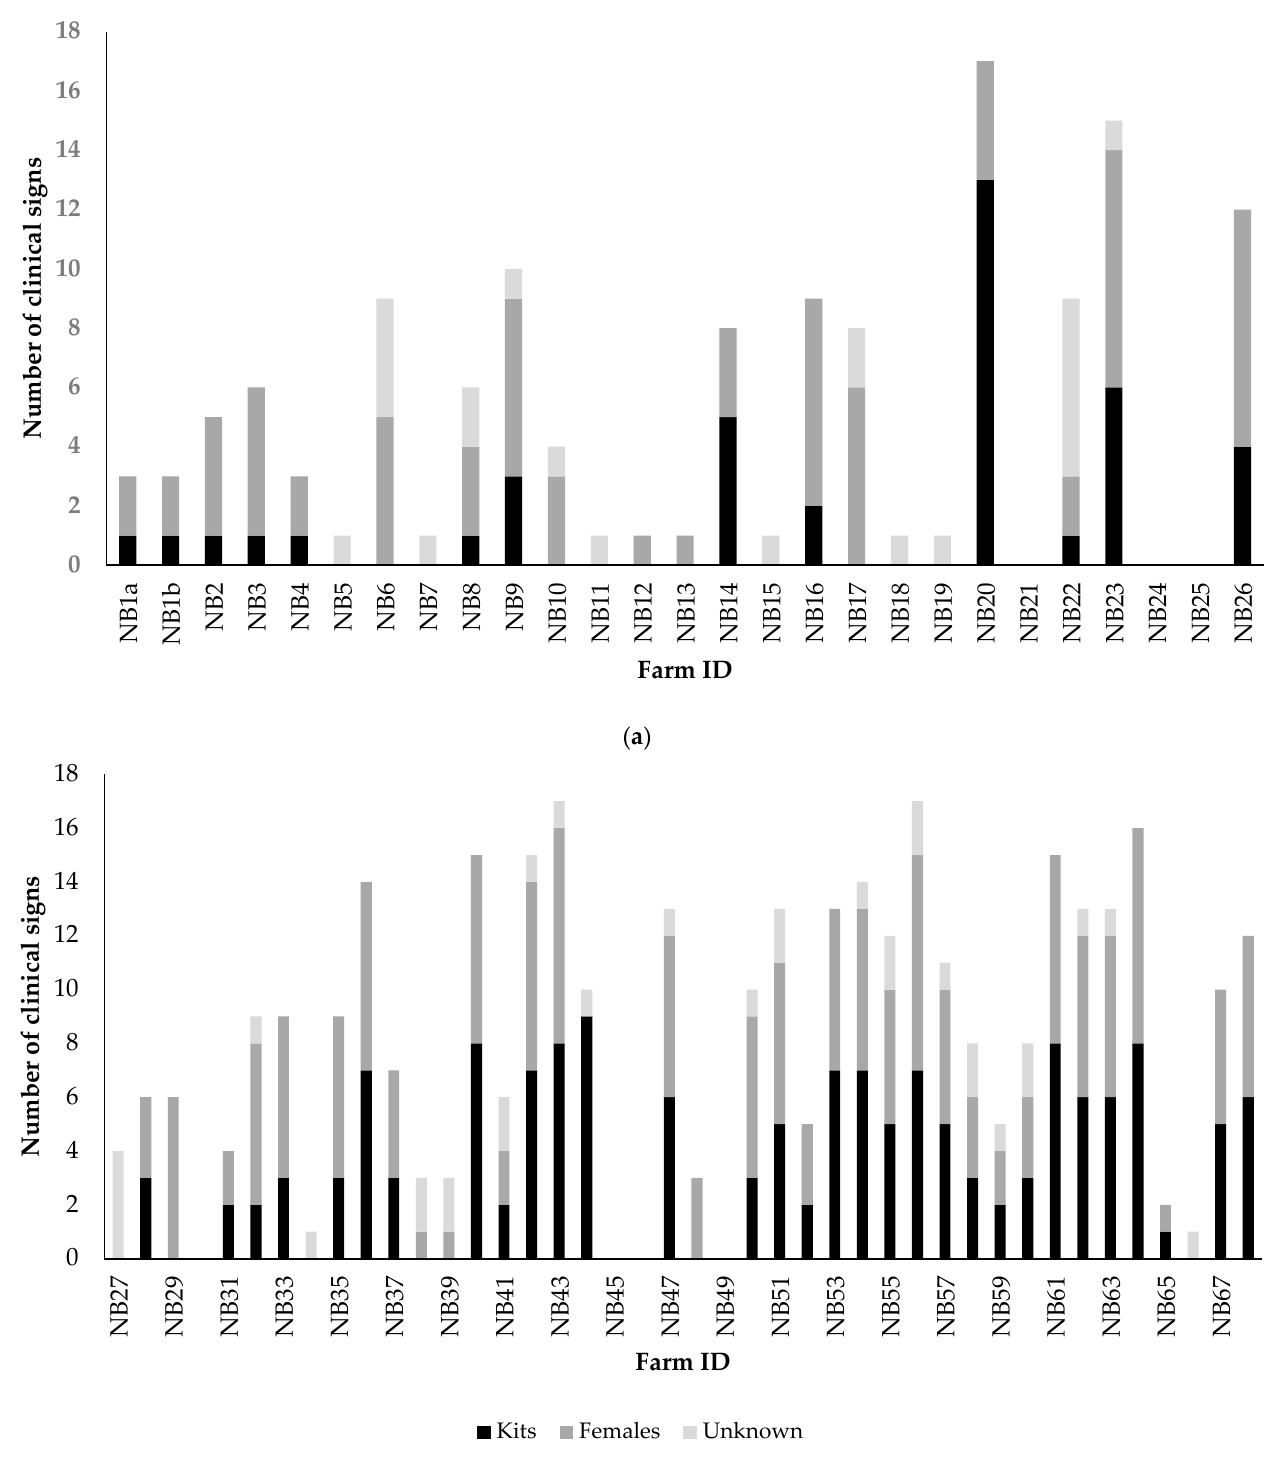
Figure 1. Overview showing per clinical sign, of the 19 different clinical signs of the standardized list (Table S1), the number of farms ( n = 62) for which the sign was observed in kits, male or female adult minks. Note that inflammation/bleeding/lesions refer to these on the gingiva.